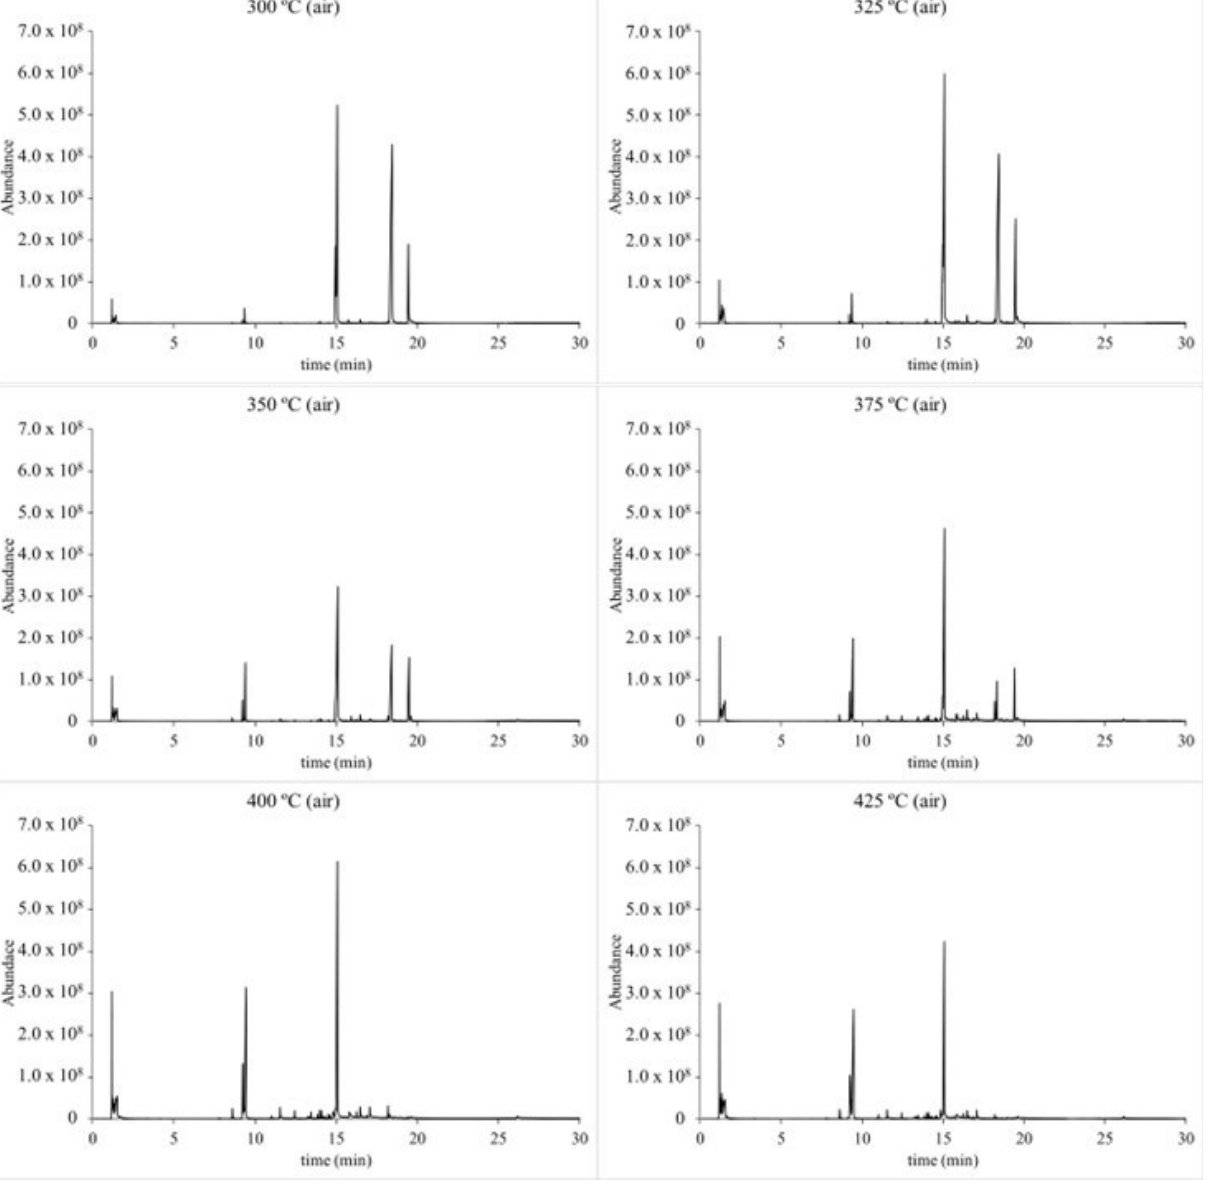
Figure 7. Chromatograms of the pyrolysis of NNN at different temperatures under the air atmos- phere.